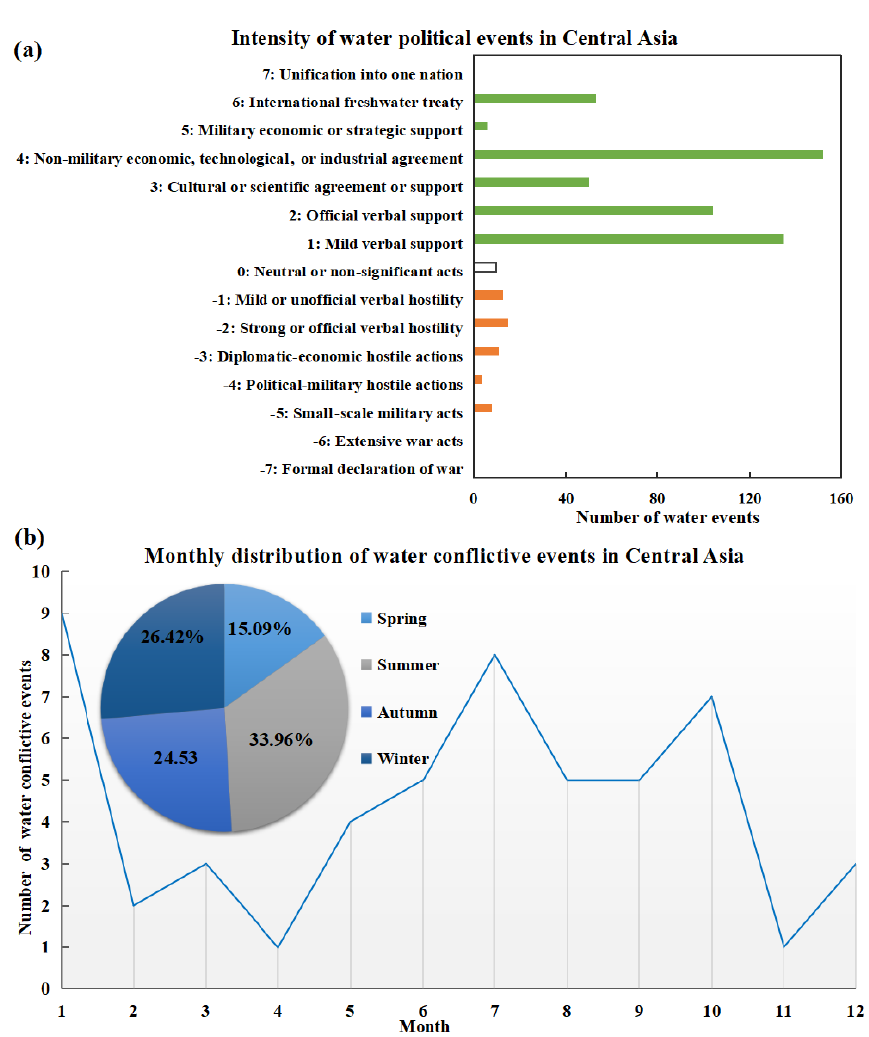
Figure 10. Graph showing (a) number of water political events in Central Asia according to intensity and (b) monthly distribution of water conflictive